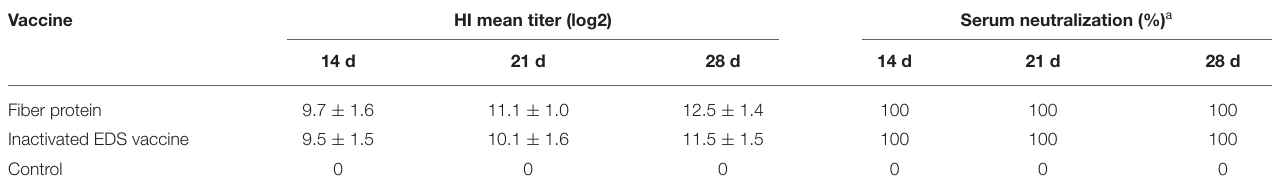
a Each number represents percent of eggs (out of six) in which the virus was neutralized.